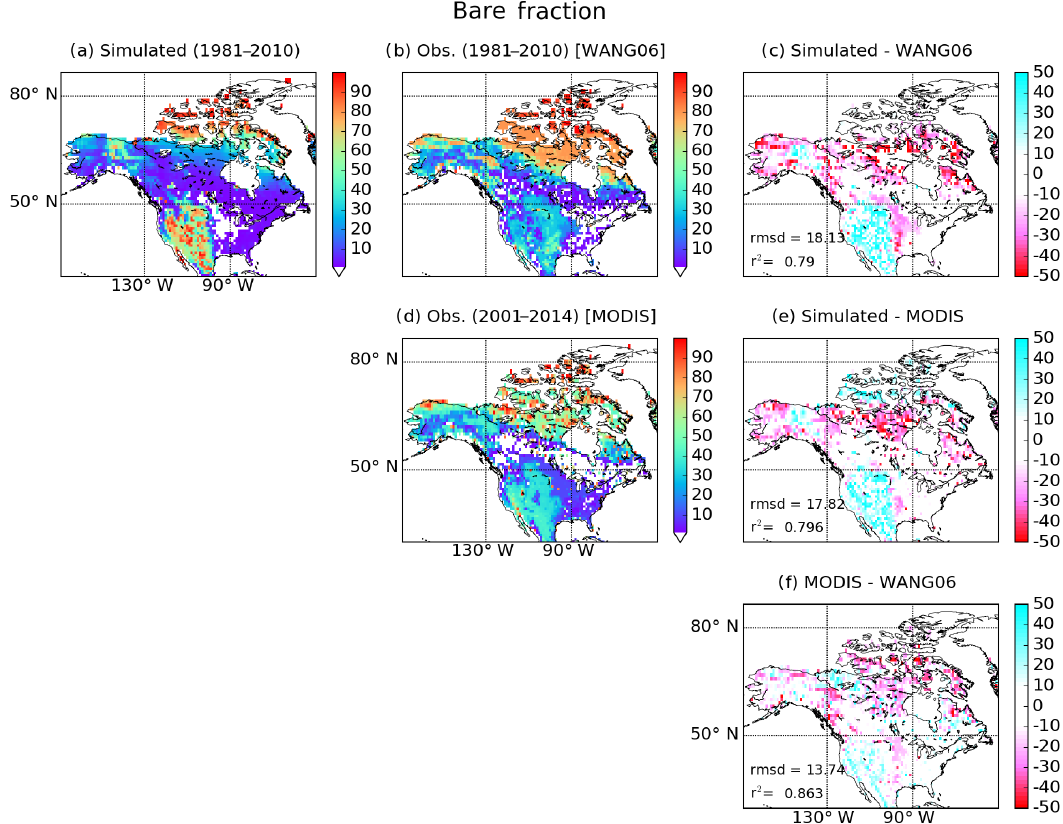
Figure 4. Spatial distribution of bare ground coverage across North America. Model-simulated results are shown in the left column (a) and the two observation-based estimates are shown in the middle column (b, d) . The right column (c, e, f) shows the difference between model- and observation-based estimates (simulated minus WANG06 in c , and simulated minus MODIS in e ), and the observation-based estimates themselves (MODIS minus WANG06 in f ) along with the root mean square difference (rmsd) and spatial correlation ( R 2 ) between the two estimates being